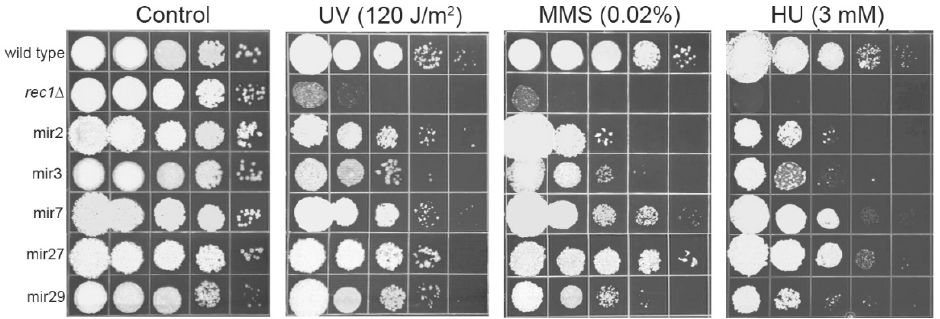
Figure 2. Response of mir mutants to genotoxic agents. Ten-fold serial dilutions of mutants were plated on solid medium then irradiated with indicated dose of UV or else plated on medium containing MMS or HU. The rec1 mutant was used as a negative control, sensitive to all used agents. The testing was performed two times and representative results are shown.